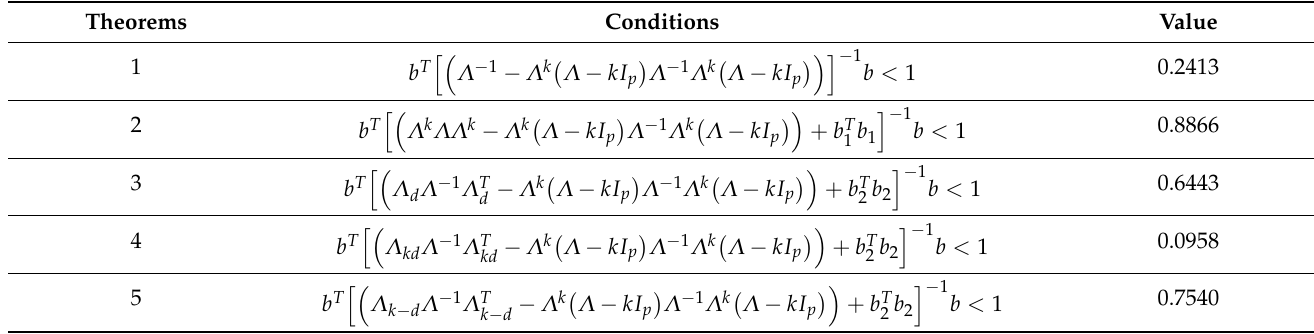
Table 5. Validation of the theoretical conditions for the cancer data.